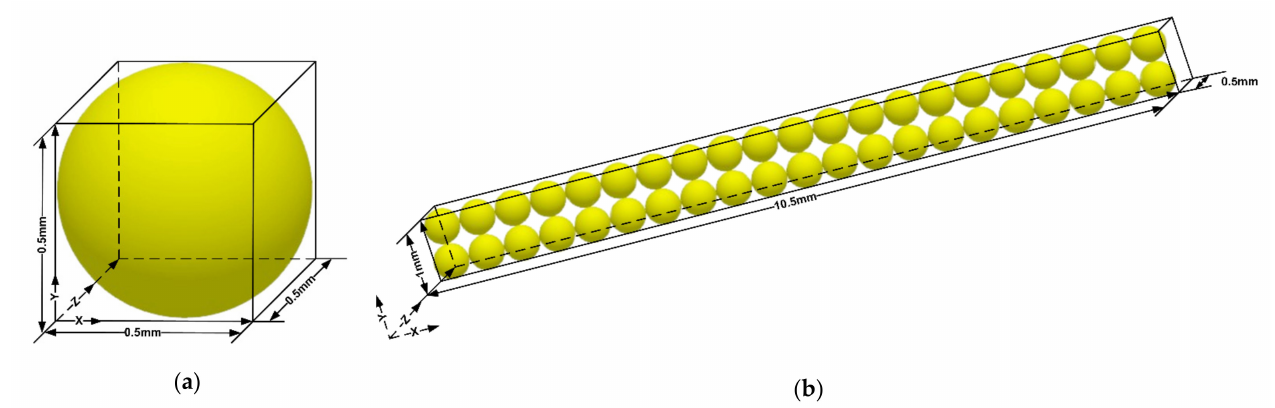
Figure 3. Straw fiber particle model. ( a ) Single spherical particles. ( b ) Lumpy particles.